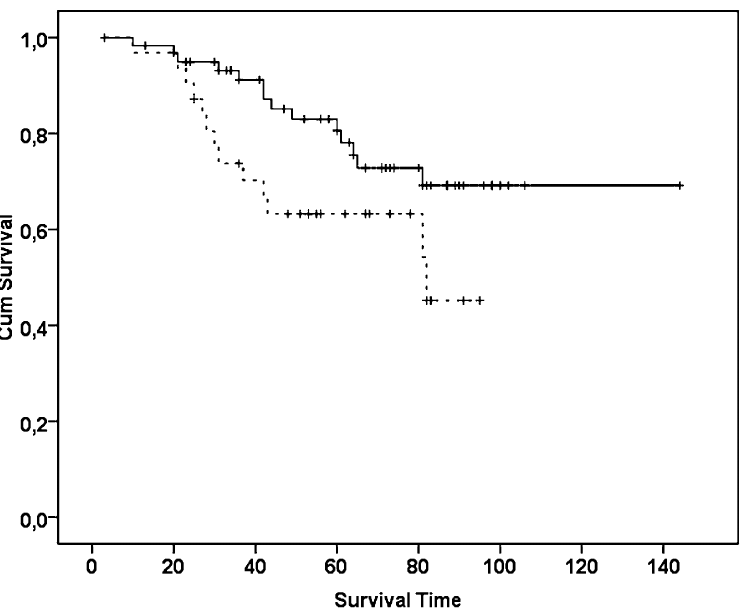
Fig. 5. Improved survival in the presence of the − 31C allele. Continuous and dotted lines represent the patients carrying the C allele and the GG homozygotes,